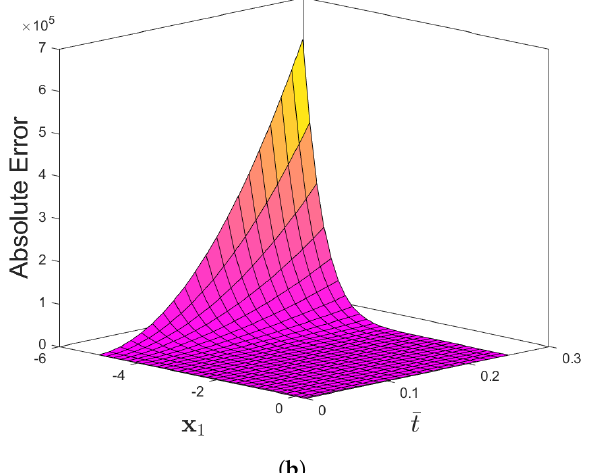
Figure 8. ( a ) Absolute-error plots of f ( x 1 , ¯ t ) for Problem 3 for ( a ) CFD and ( b ) ABC when the parameters are θ = 1, β = 6 and ϕ = 0.